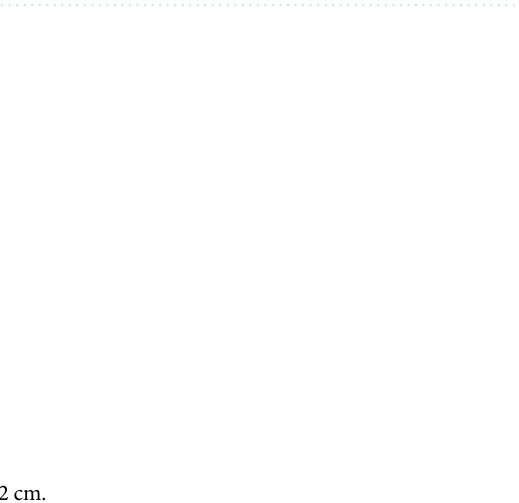
Figure 3. Photograph of the compression shear test showing a specimen ready to be tested.